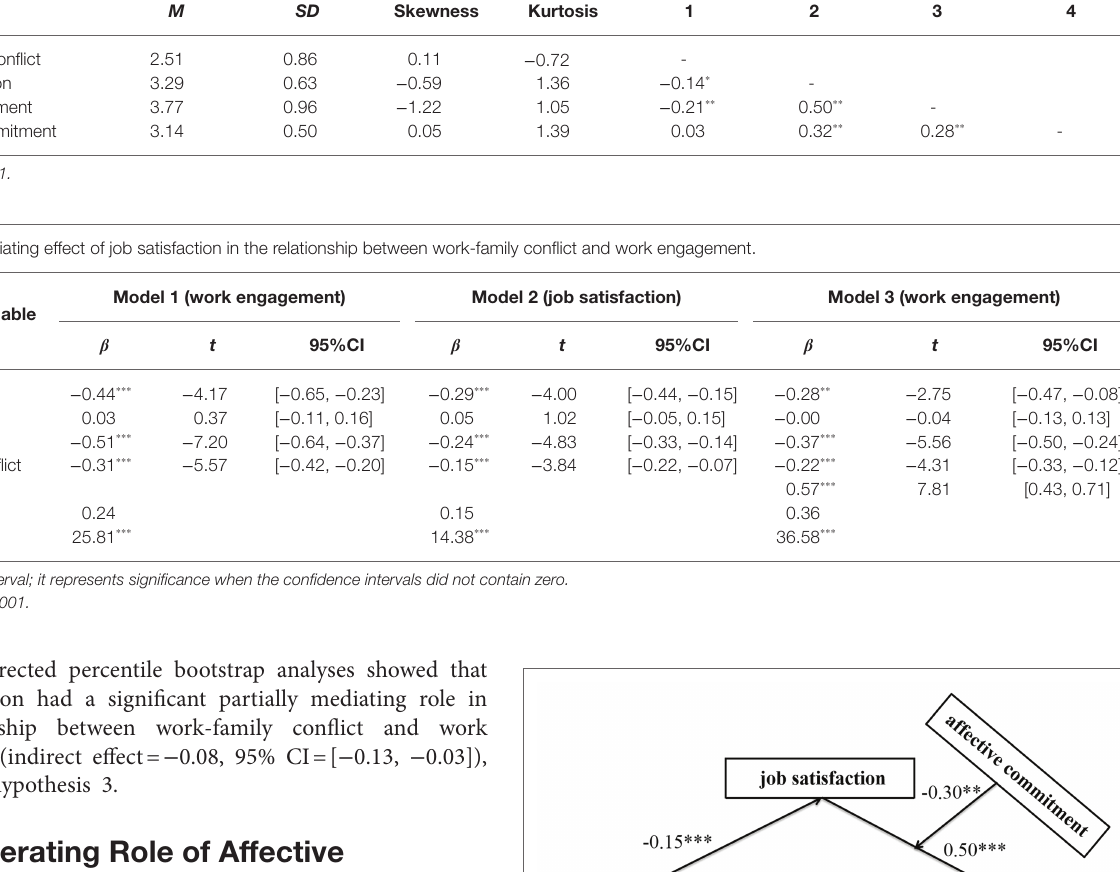
TABLE 2 | Descriptive statistics and correlations between study variables. Variable M 1. Work-family conflict